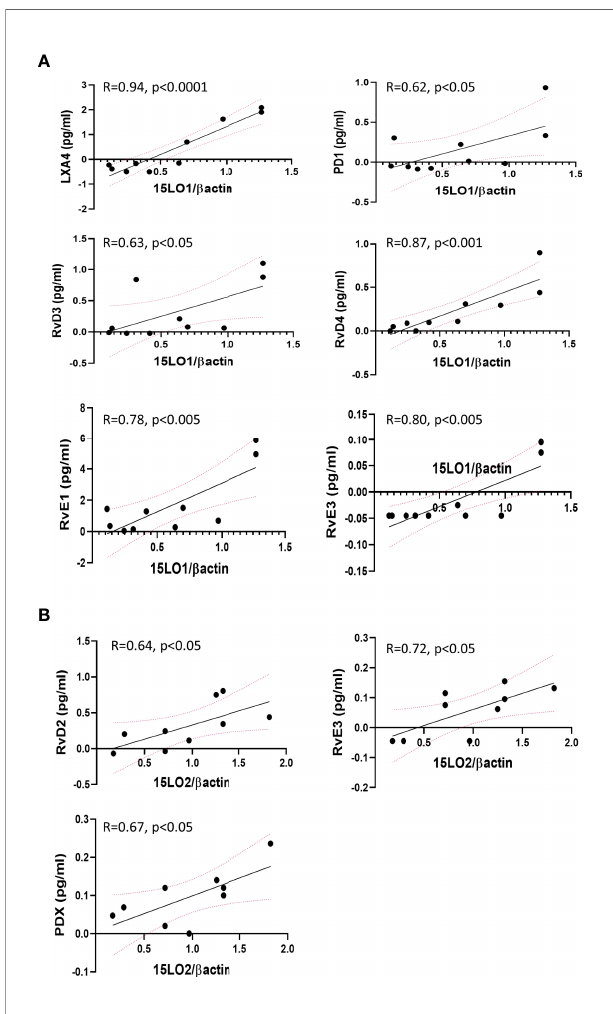
FIGURE 8 | Selected signi fi cant Pearson ’ s correlations between enzymes expression levels and SPMs biosynthesis by the same hNEC sample. (A) Positive correlations between 15-LO1 and SPMs in CF hNEC. (B) Positive correlations between 15-LO2 and SPMs in non-CF